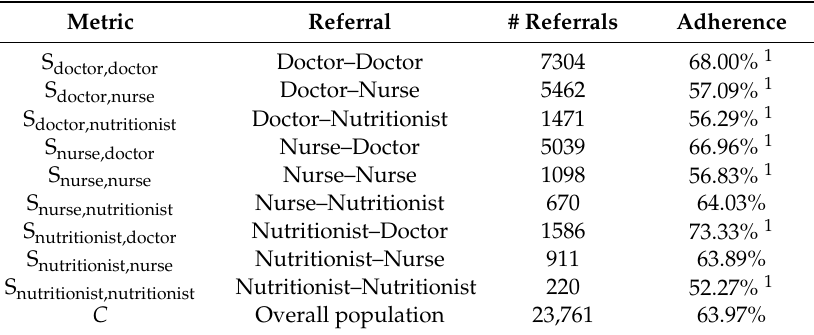
Table 3. Specific referral